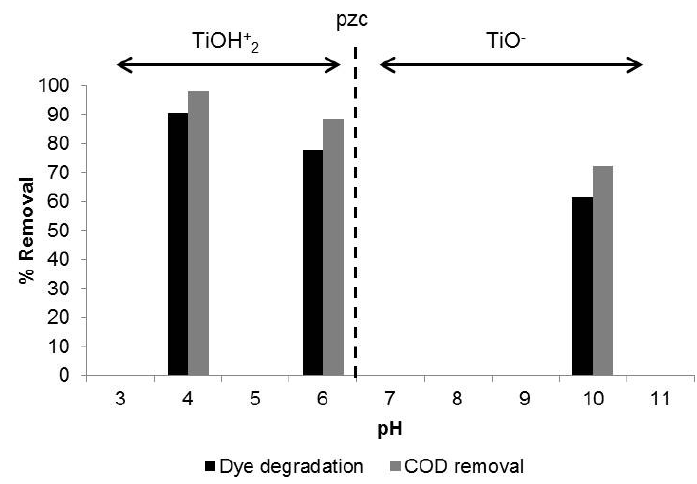
Figure 4. Influence of pH solution on the degradation of